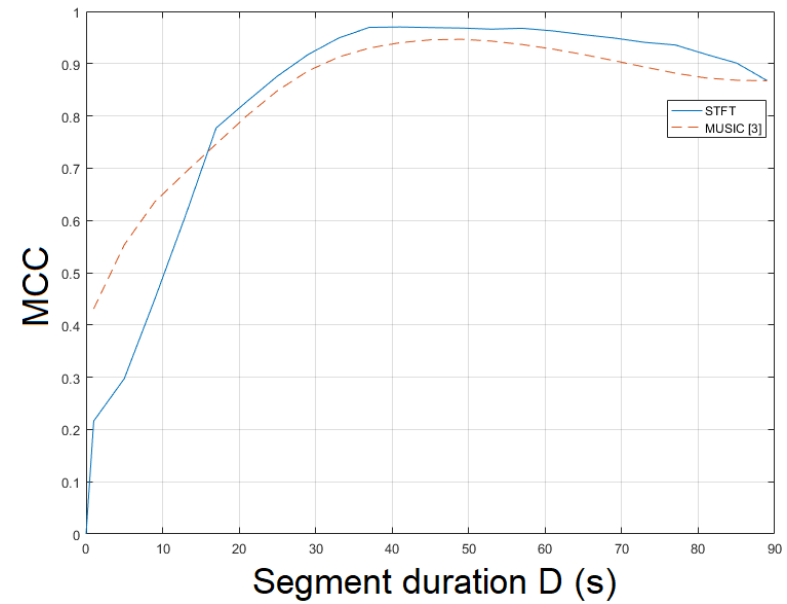
Figure 4. Maximum correlation coefficient of the proposed approach employing SLIC+STFT for various segment durations against the MUSIC [3] (mov2).